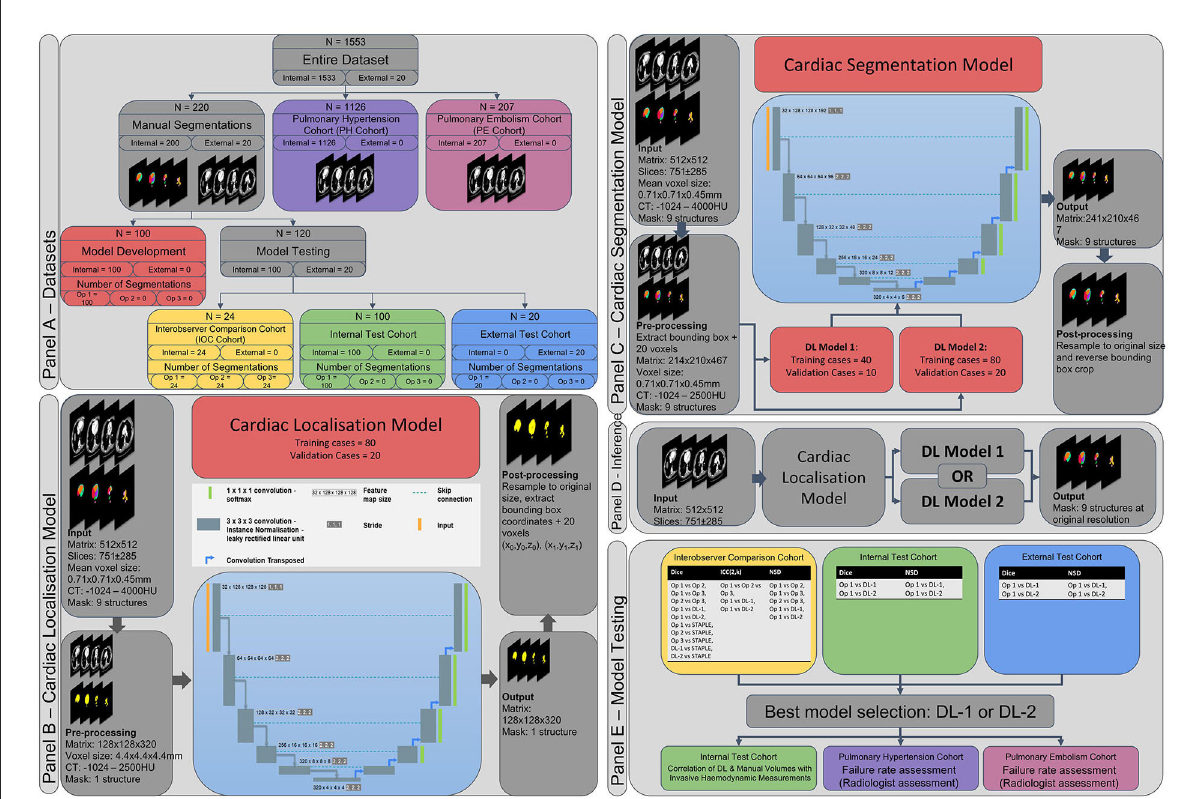
FIGURE1 Methodology. (A) Datasets used within this study. (B) Cardiac localisation deep learning model. (C) Cardiac segmentation deep learning model. (D) Inference pipeline. (E) Model testing strategy. Ob 1, 2, 3, observer 1, 2, 3; DL-1, deep learning model 1; DL-2, deep learning model 2; Dice, dice similarity score, ICC, intraclass correlation coefficient; NSD, normalised surface distance (Surface Dice